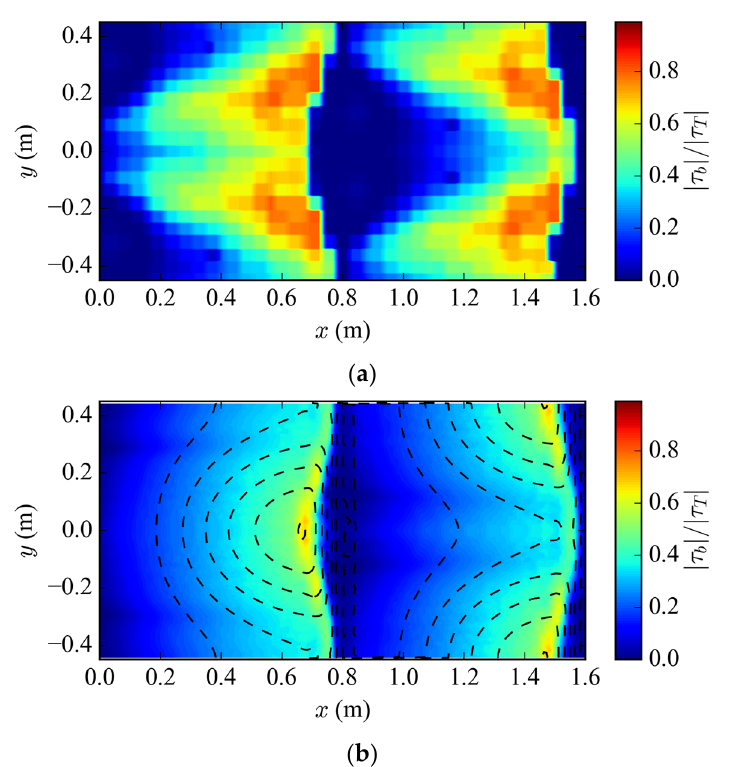
Figure 12. The comparison of streamwise velocity from simulation and experiment. ( a ) The streamwise velocity at y = 0 m; ( b ) the streamwise velocity at y = 0.225 m.